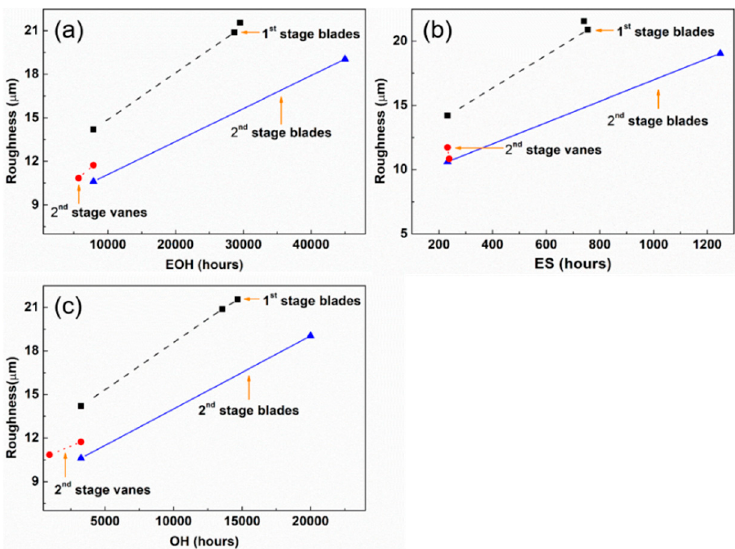
Figure 4. The controls on blade and vane roughness: The effect of ( a ) the equivalent operating hours (EOHs), ( b ) equivalent stop (ES), and ( c ) operational hours (OH) on the blade and vane roughness.